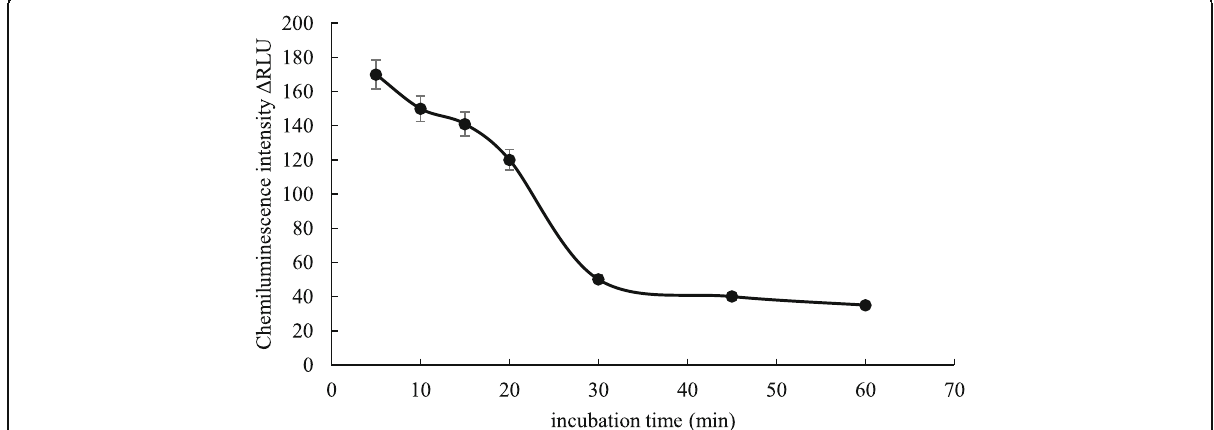
Fig. 7 The graph shows the effect of different incubation time on the CL signal after the addition of 30 μ l of 50 ng ml − 1 of cortisol standard